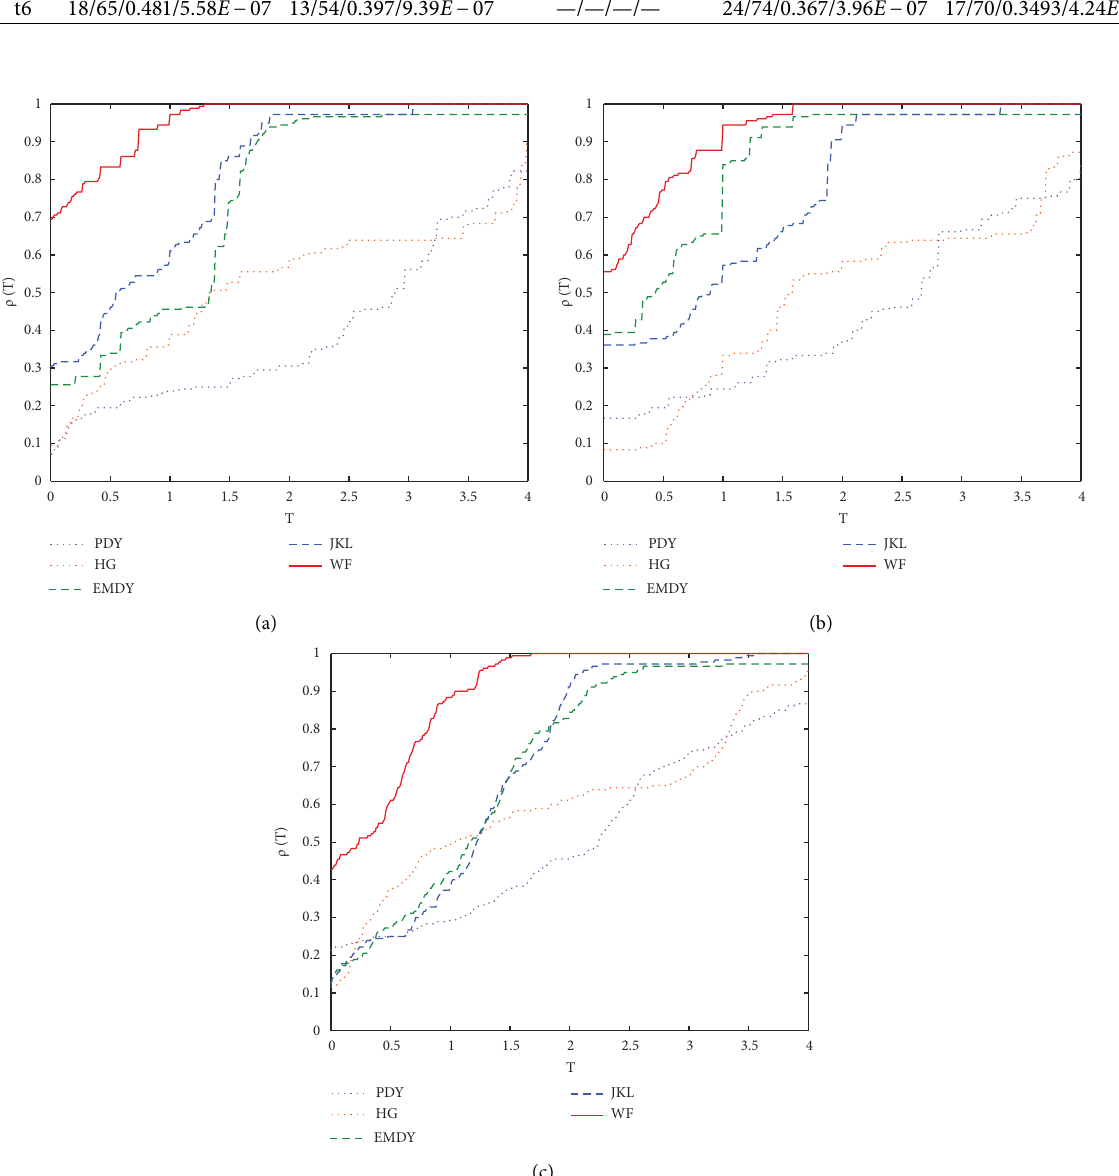
Figure 1: (a) Performance profle on NG. (b) Performance profle on NI. (c) Performance profle on